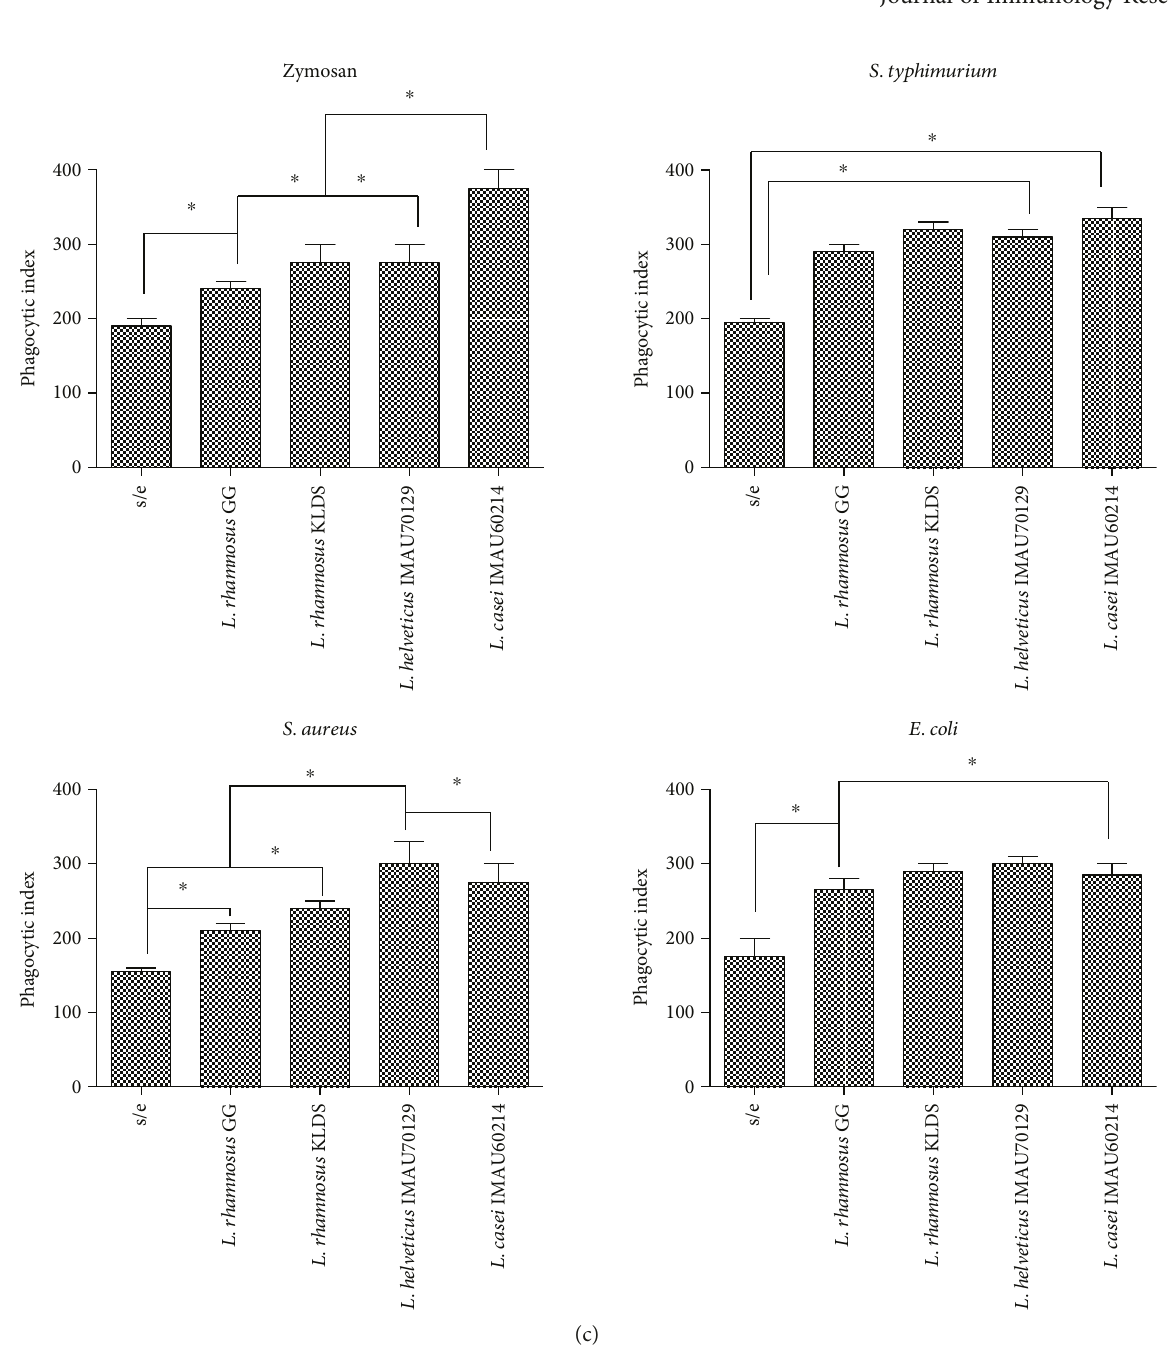
Figure 3: E ff ect of heat-killed lactobacillus on phagocytosis in human macrophages. Cells (1 × 10 4 ) were treated with heat-killed strains of lactobacillus at a MOI of 1 :500 for 1 h before zymosan particles, S. aureus , S. typhimurium , or E. coli (each at a MOI of 1: 10) were added. Phagocytosis was allowed to proceed for 1 h at 37 ° C in an atmosphere containing 5% C0 , before phagocytosis was terminated. The cells 2 were then fi xed, and the nuclei were stained with DAPI. Macrophages, untreated (a) and treated (b) cells. Fluorescence photomicroscopy in macrophages treated with di ff erent stimuli was performed using an epi fl uorescence Zeiss Axioskop2 microscope equipped with a Zeiss Axiocam (Zeiss AG, Oberkochen, DE). This fi gure shows the representative results with the strain ( L. casei IMAU60214). (c) Heat-killed lactobacillus enhanced the phagocytic index of human macrophages. The ingestion of cells was determined in macrophages that were incubated in medium alone or preincubated with lactobacillus strains. The following formula was used: the percentage of cells undergoing phagocytosis × the number of particles per cells. The cells were incubated with zymosan, S. typhimurium , S. aureus , and E. coli , as indicated. Asterisks indicate a signi fi cant di ff erence between conditions ( p > 0 05